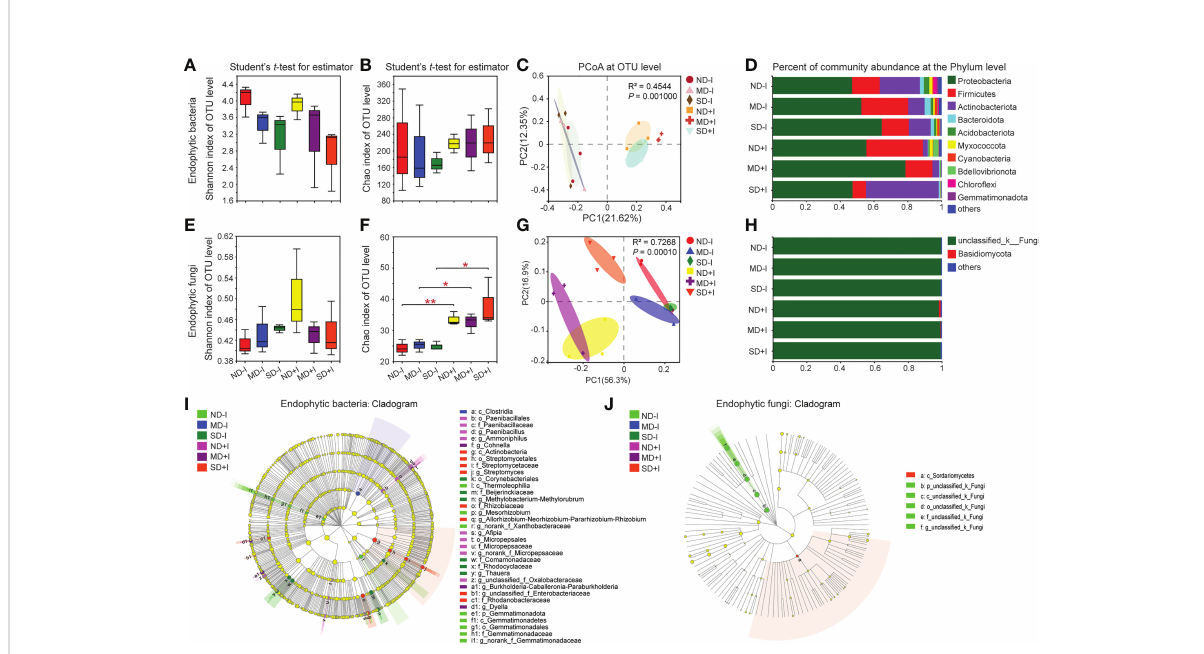
FIGURE 4 Diversity and community structure of rhizosphere bacteria and fungi of A. lancea . Shannon index (A, E) shows a diversity, Chao1 index (B, F) shows richness, both at the OTU level. C and G: PCoA of endogenetic bacteria (C) and Fungi (G) in A. lancea based on Bray-Curtis and unweighted UniFrac matrix at OTU level, respectively (n = 3). D and H: Bar chart of endogenetic bacteria (D) and fungi (H) in A. lancea endogenetic at phylum level. I and J: Phylogenetic maps of endogenetic bacterial (I) and fungal (J) lineages of A. lancea . Asterisks represent signi fi cant difference by Student ’ s t-test: *P < 0.05; ** P < 0.01; ND, no drought stress, 0% PEG6000; MD, mild drought stress, 10% PEG6000; SD, severe drought stress, 25% PEG6000; +I, with Geo-authentic soil microbe